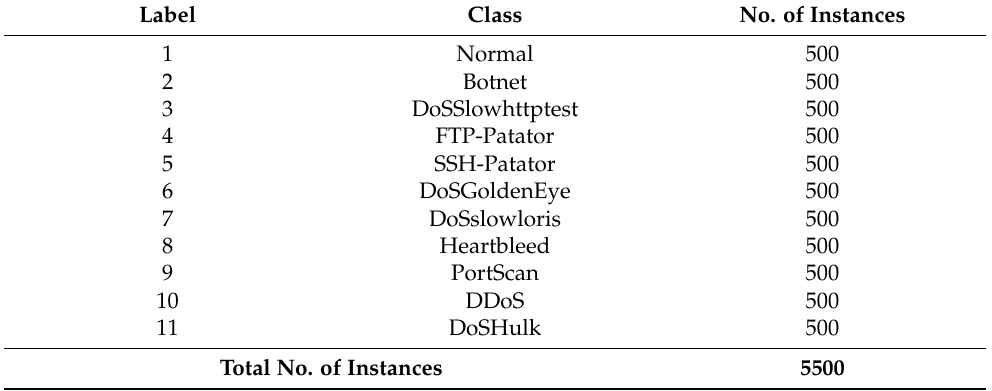
Table 1. Dataset details.